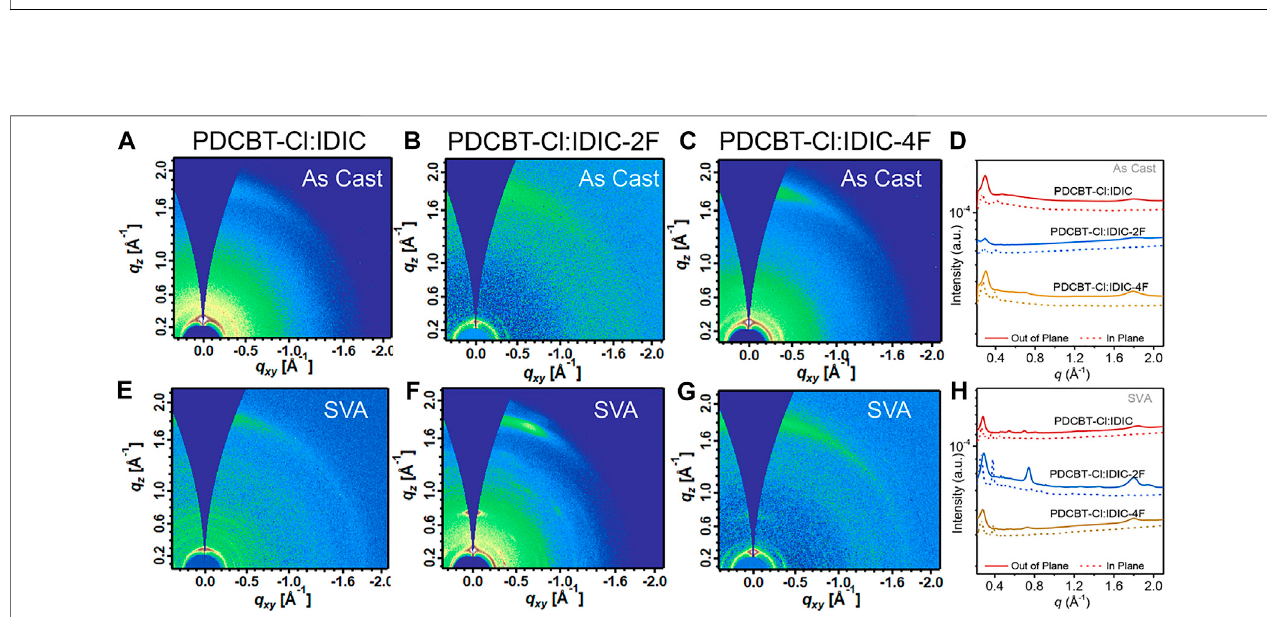
FIGURE 4 | 2D GIWAXS patterns for (A) IDIC (B) IDIC-2F (C) IDIC-4F-based blends of the fresh fi lms and (E) IDIC (F) IDIC-2F (G) IDIC-4F-based blends with solvent vapor annealing for 60s (D) 1D pro fi les derived from (A) to (C) and (H) derived from (E) to (G) .